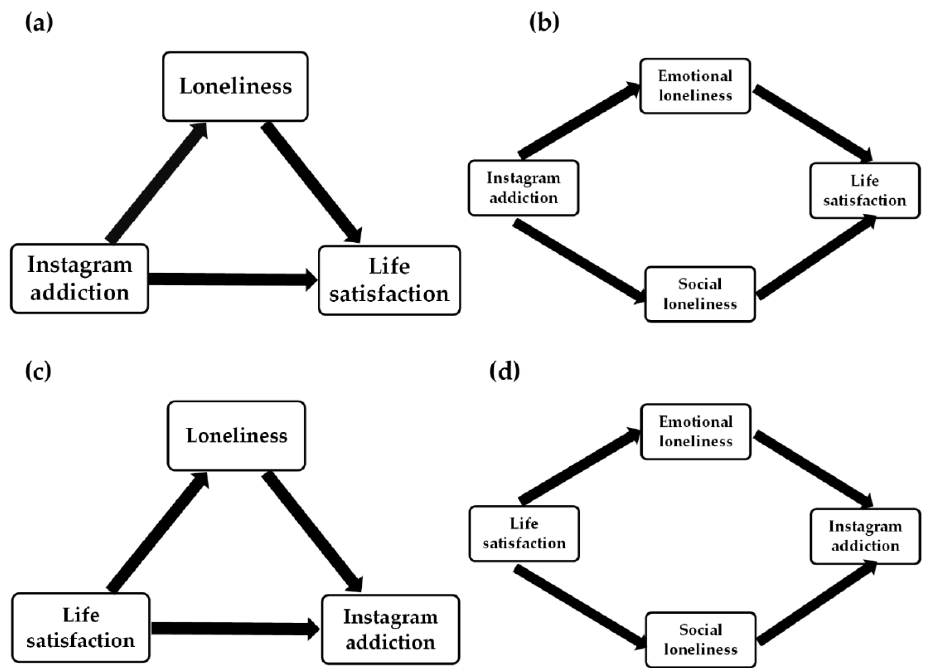
Figure 1. Hypothetical mediating role of loneliness in the relationship between: ( a ) Instagram addiction and life satisfaction (single mediation); ( b ) Instagram addiction and life satisfaction (parallel mediation); ( c ) life satisfaction and Instagram addiction (single mediation); ( d ) life satisfaction and Instagram addiction (parallel mediation).